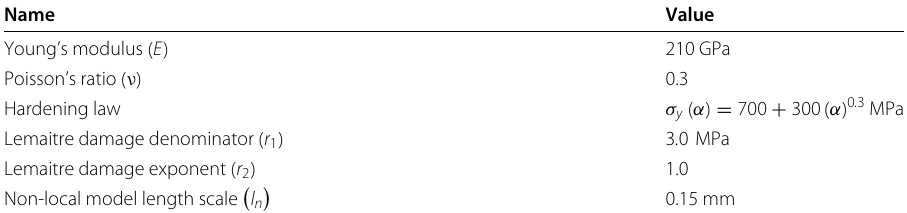
Table 2 Material parameters for the notched